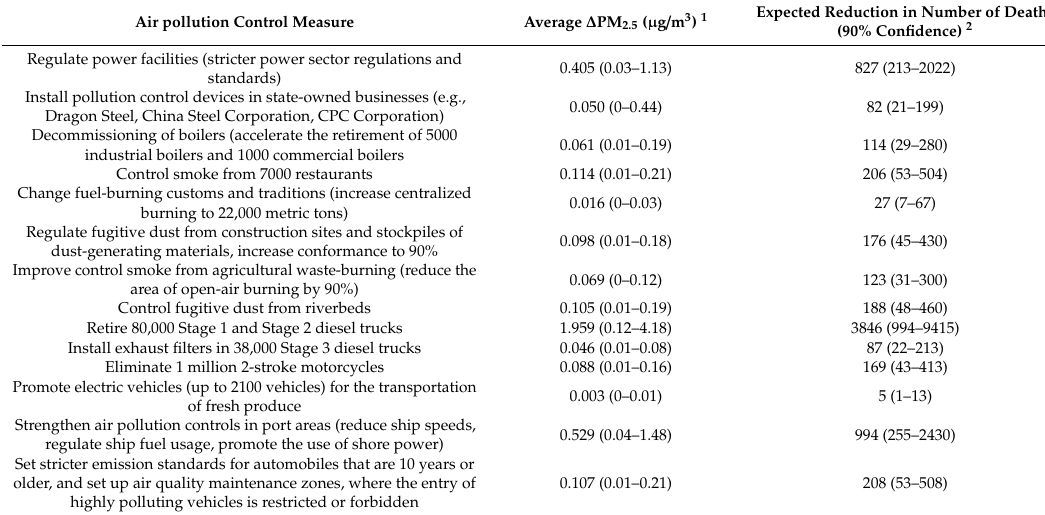
Figure 3. PM 2.5 reduction concentration and the expected reductions in the number of deaths of TAPCAP implement. ( a ) PM 2.5 reduction concentration of TAPCAP ( μ g/m 3 ). ( b ) Estimated PM 2.5 related health impact (number of preventable deaths) due to ( a ). Table 3. Improvement in air quality and health impact due to each pollution control measure under the 14 air pollution control strategies